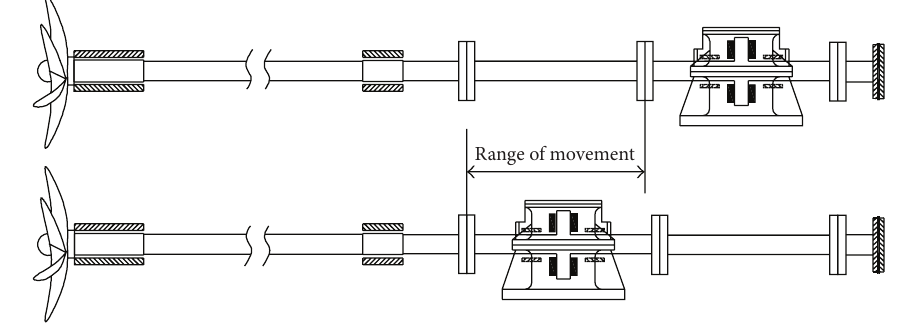
Figure 17: The range of thrust bearing movement.